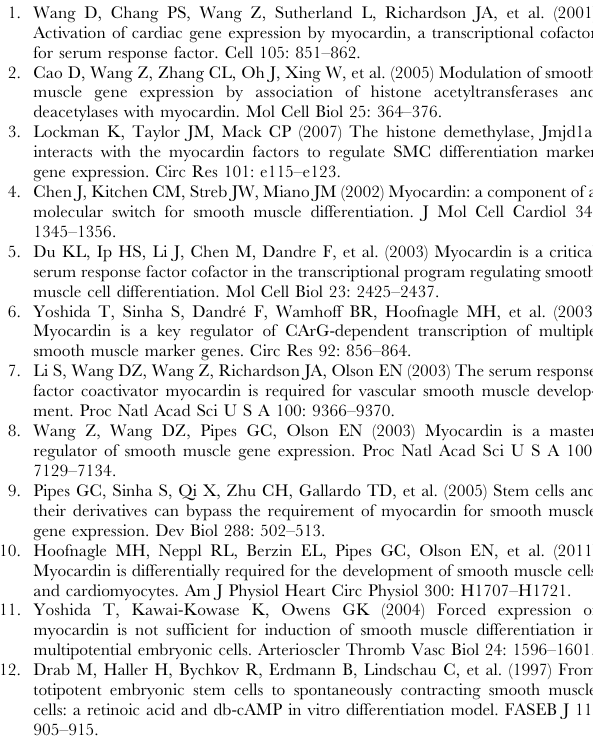
tion. The percentage change of cell surface area was determined from 20 contracting cells selected randomly from 10 different optical fields. (***p , 0.001). (PDF) Figure S5 Reduced myocardin-FLAG transgene expres- sion with embryoid body maturation. Embryoid bodies were treated with Ad-LacZ or Ad-Myo from day 10 onwards and dispersed and fixed for flow cytometry at day 21 (A–C) or day 28 (D–F). The subset of cells transduced with the Ad-Myo virus was identified by flow cytometric detection of the 3 9 FLAG tag fused to the myocardin transgene, which was higher at day 21 than day 28. The effect of myocardin-FLAG transgene expression on %SMMHC + cells was analysed by flow cytometry. The majority (88–89%) of FLAG + Ad-Myo transduced cells demonstrated a SMC-like phenotype.